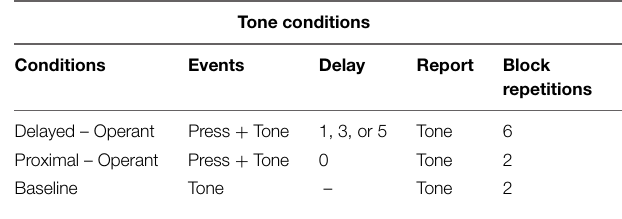
TABLE 3 | Experimental